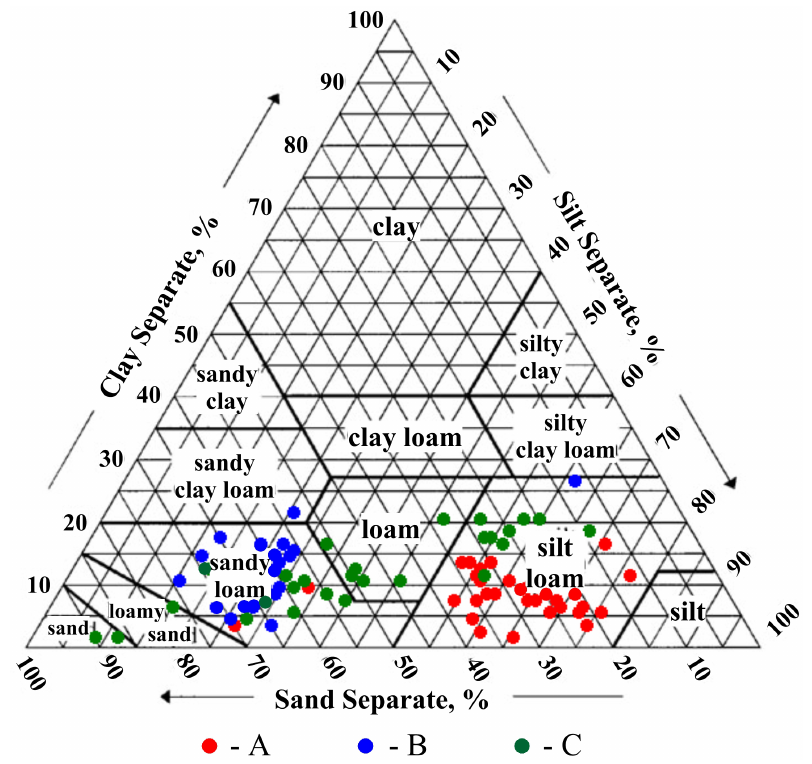
Figure 4. Classification of soils collected from the analyzed experimental sites A, B,